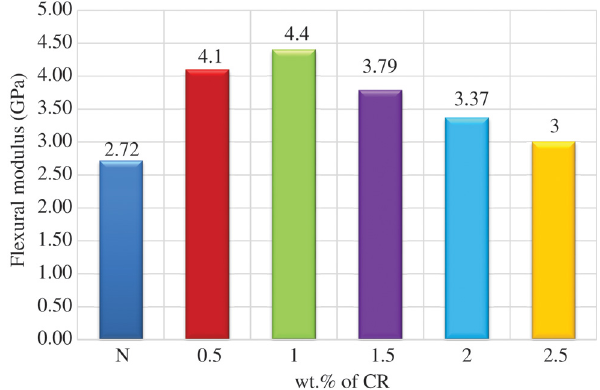
Figure 26: Flexural modulus for various compositions of CFR composite.